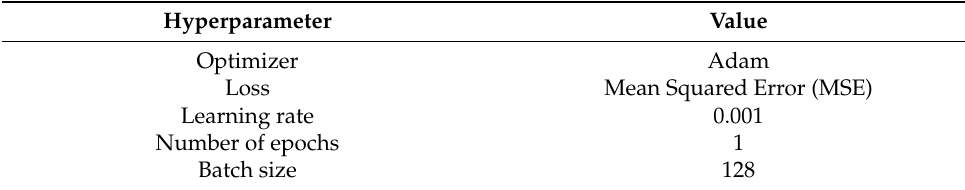
Table 5. The set hyperparameters for the designed convolutional autoencoder in feature extrac- tion part.